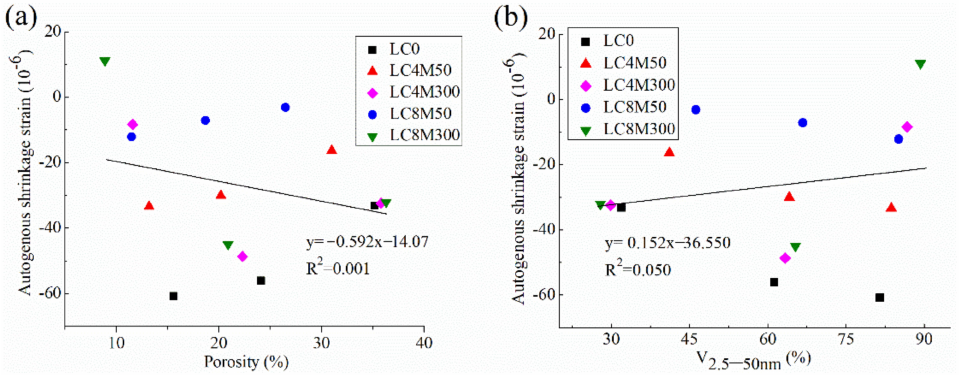
Figure 6. Correlation of autogenous shrinkage with ( a ) porosity and ( b ) V 2.5–50 nm